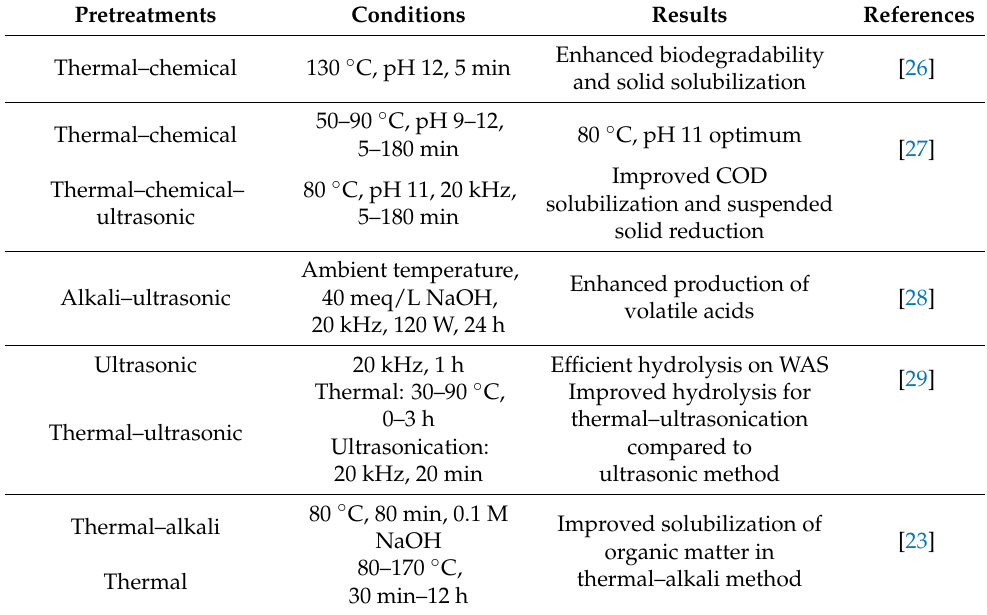
Table 1. Summary of combined pretreatment